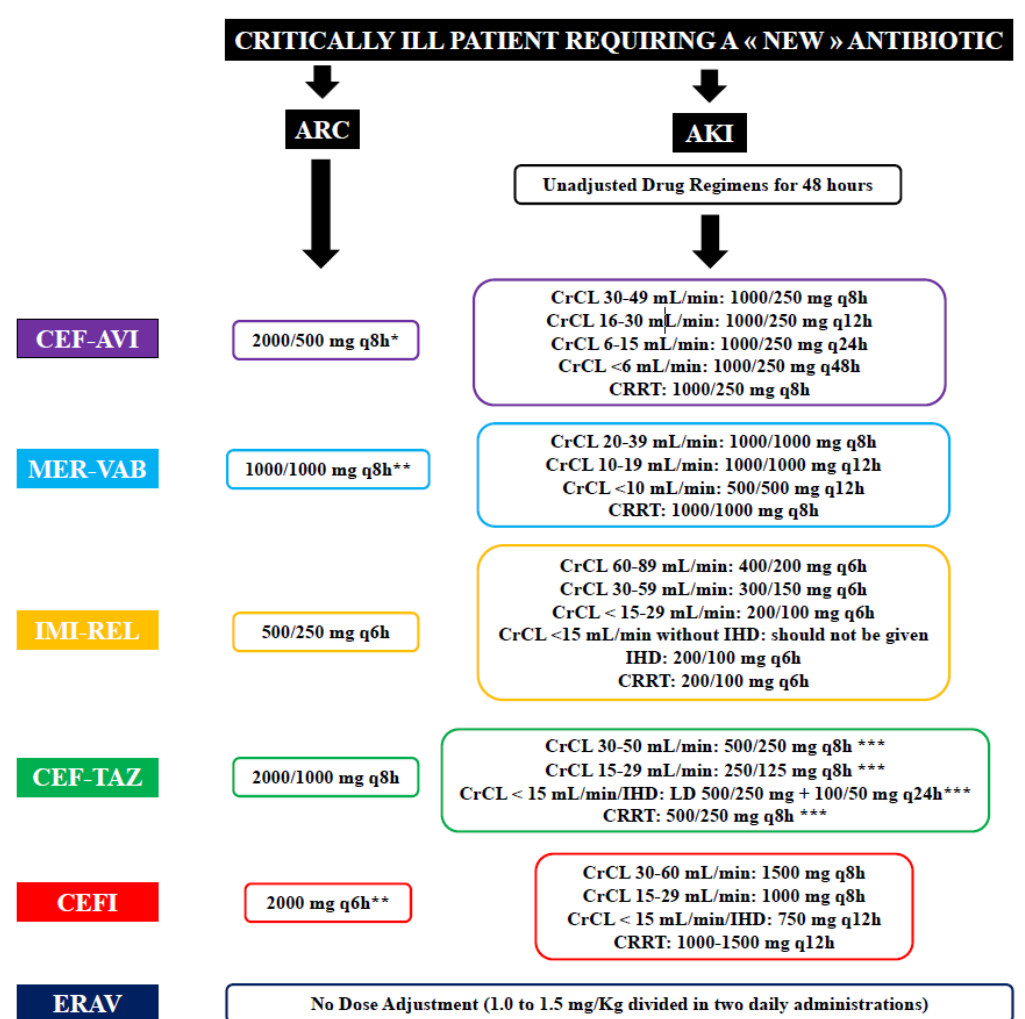
Figure 1. Summary of dose adjustment for patients with augmented renal clearance (ARC) or